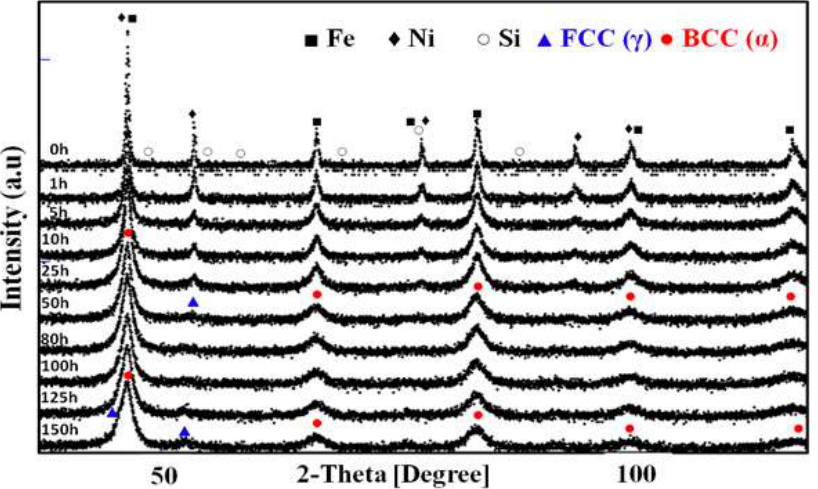
Figure 2. X-ray diffraction patterns of Fe 70 Ni 12 B 16 Si 2 powders as a function of mechanical alloying time.